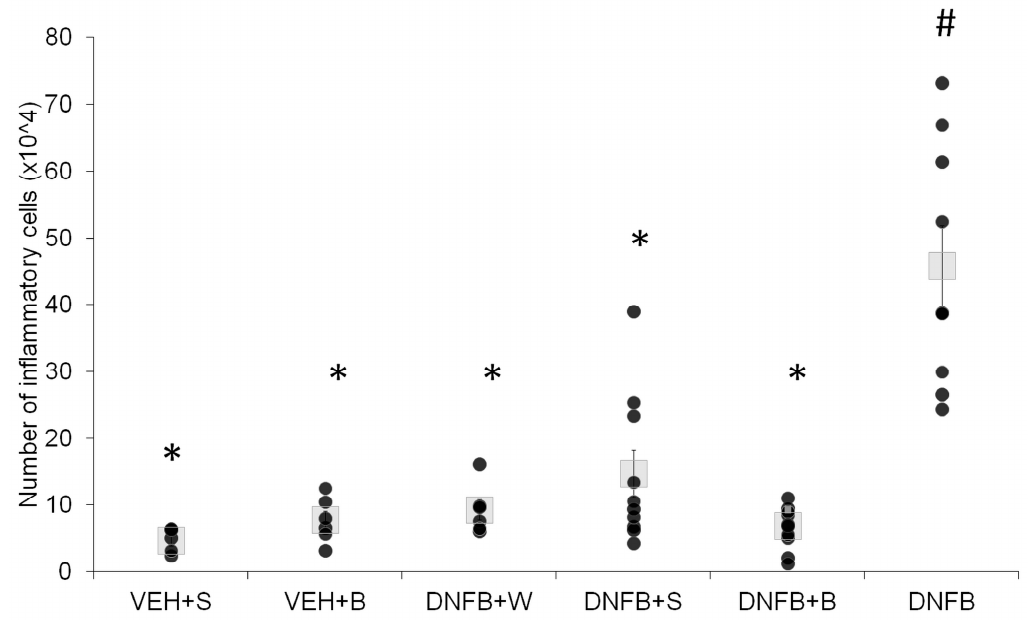
Figure 2. Total number of inflammatory cells per lung. # p < 0.05 vs. VEH + S (Mann–Whitney U test); * p < 0.05 vs. DNFB (Mann–Whitney U test); means ± SE, n = 6–10; VEH + S, sham-sensitized saline-inhaled; VEH + B, sham-sensitized brine-inhaled; DNFB + W, sensitized pure water inhaled; DNFB + S, sensitized saline inhaled; DNFB + B, sensitized brine inhaled; DNFB, sensitized non-inhaled.